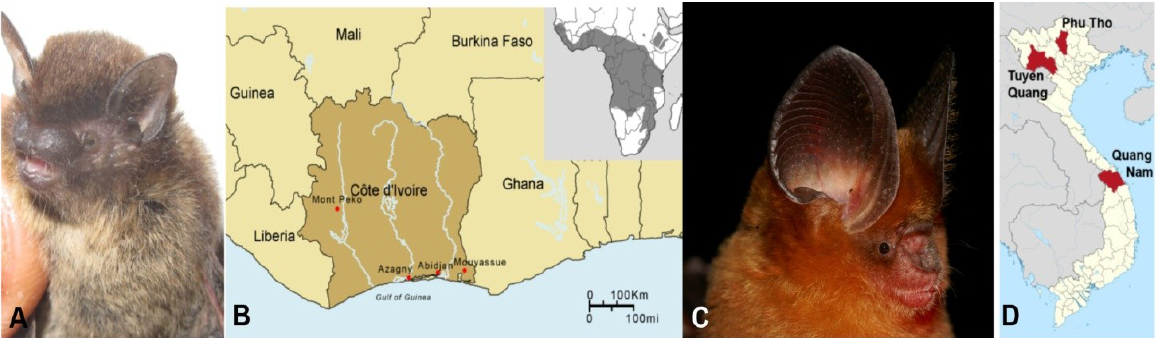
Figure 2. ( A ) Banana pipistrelle ( Neoromicia nanus ); ( B ) Map of Cote d’Ivoire, showing site where Mouyassué virus-infected banana pipistrelles were captured during June 2011; inset shows geographic distribution of banana pipistrelle; ( C ) Pomona roundleaf bat ( Hipposideros pomona ); ( D ) Map of Vietnam, showing Phu Tho, where Xuan Son virus (XSV) was first discovered, and Tuyên Quang and Quang Nam, where Pomona roundleaf bats were captured in May 1997 and March 1999, respectively; ( E ) Comparison of the consensus secondary structures of the nucleocapsid protein of XSV, Longquan virus (LQUV), Nova virus (NVAV), Thottapalayam virus (TPMV), Imjin virus (MJNV), Hantaan virus (HTNV), Dobrava virus (DOBV), Seoul virus (SEOV), Puumala virus (PUUV), Sin Nombre virus (SNV) and Andes virus (ANDV), as predicted using methods available on the NPS@ structure server [32]. Alpha helices are represented by blue bars, beta strands by red bars, and random coils and unclassified structures by magenta and gray bars,